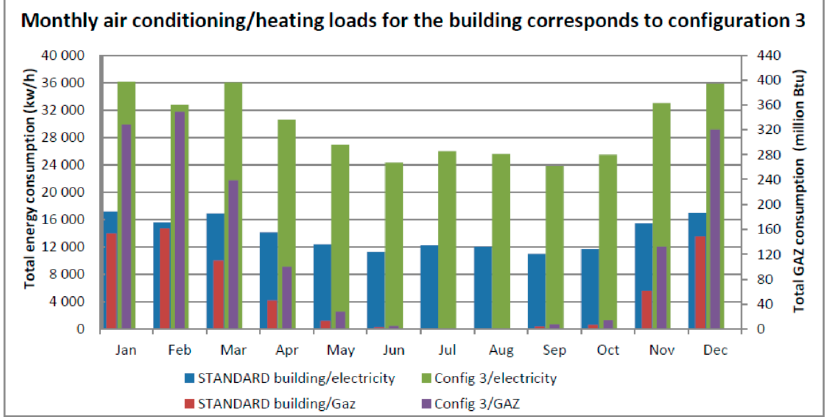
Figure 10. Monthly air conditioning/heating loads required to maintain the thermal comfort for the configuration 3 building compared to the loads required for the standard